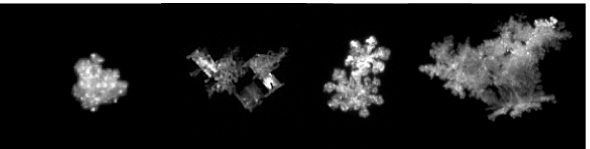
Figure 3. MASC-captured images of snowflakes as observed at the NSA Barrow Climate Research Facility site.